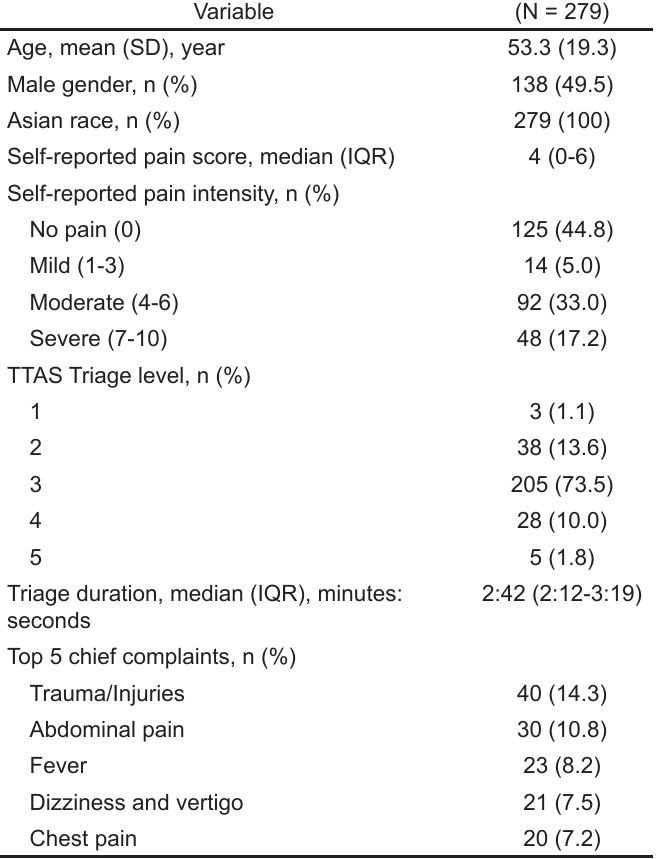
Table 1. Baseline clinical characteristics of emergency department patients.